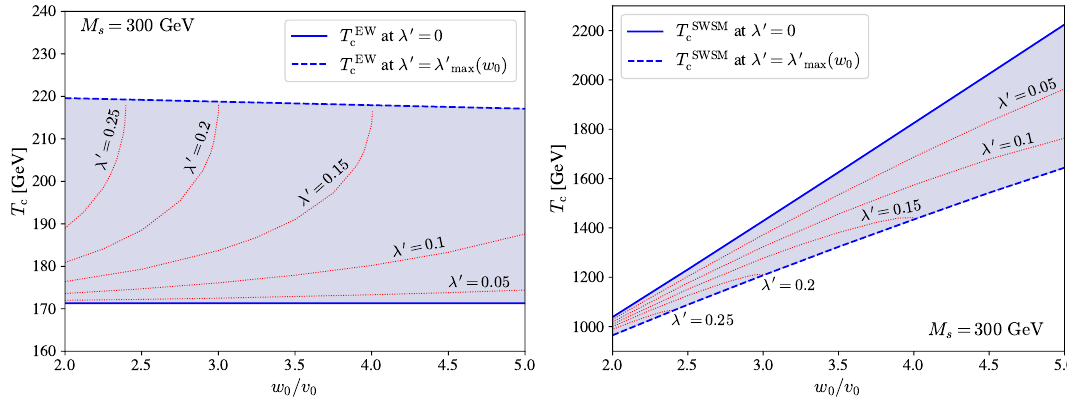
Figure 8 . Critical temperatures for the EW ( T EW , left panel) and SWSM phase transitions c ( T SWSM , right panel) for fixed singlet scalar mass M s , and RHN mass M N = 150 GeV. The blue c shaded region indicates the possible critical temperature ranges. The red dotted lines are the critical temperatures at constant values of the scalar mixing parameter λ 0 , while the blue dashed line shows the critical temperatures calculated at λ 0 , which is a function of w 0 (cf. eq. (3.12)). max